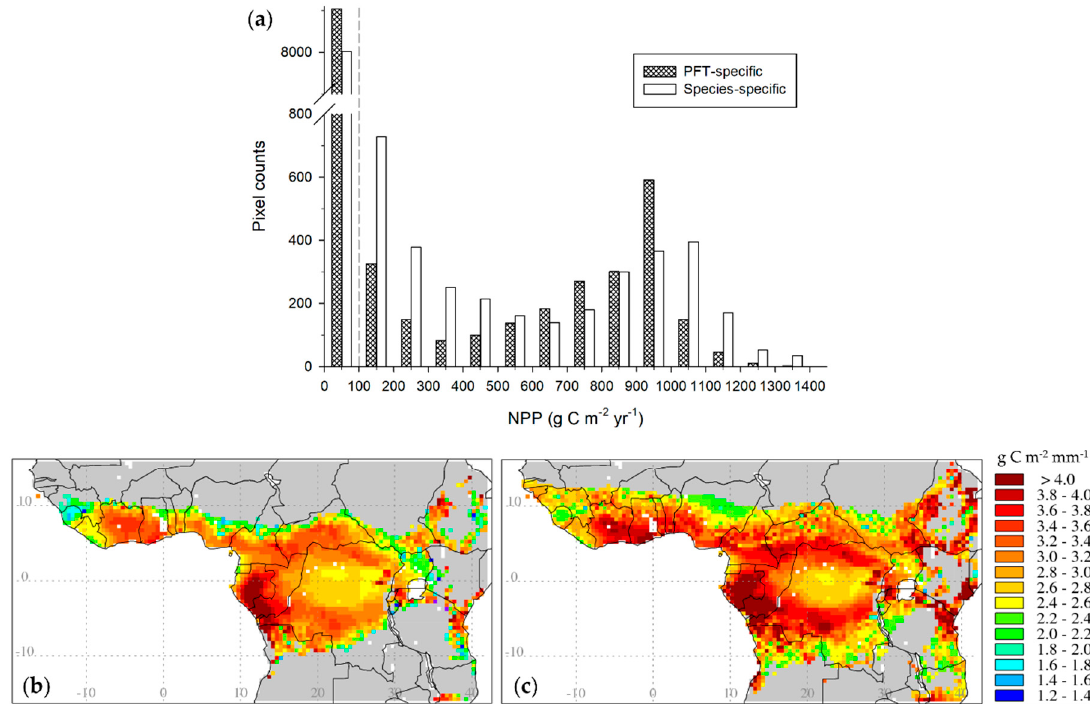
Figure 2. Net primary productivity and water use efficiency of the species Pycnanthus angolensis . ( a ) Frequency distribution histogram of simulated NPP (g C m − 2 yr − 1 ), using respectively PFT- (hatched bars) and species-specific (white bars) morpho-physiological traits (see Table 2). Dotted line indicates the 100 g C m − 2 yr − 1 NPP threshold. Annual mean water use efficiency (g C m − 2 mm − 1 ), using ( b ) PFT- and ( c ) species-specific traits. Simulations were obtained with CRU historical climatic data for the reference 1980–1999